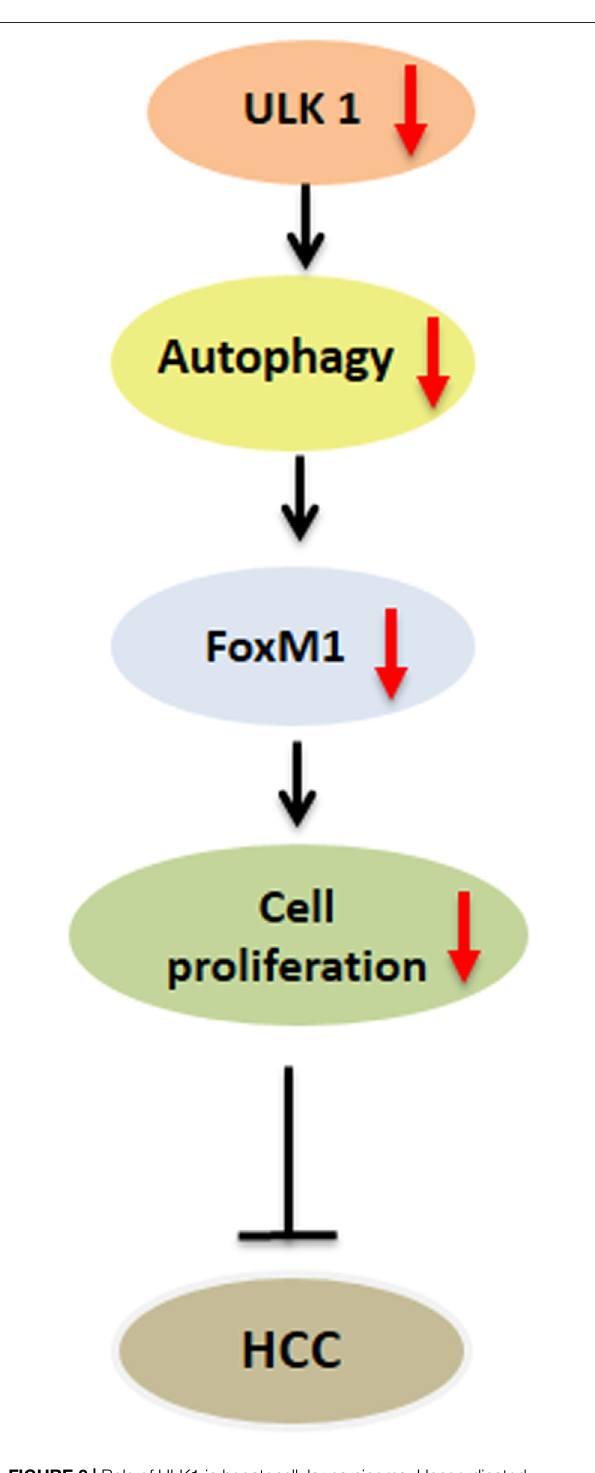
FIGURE 3 | Role of ULK1 in hepatocellular carcinoma. Uncoordinated- 51-like kinases 1 (ULK1)/autophagy inhibition reduces the expression of forkhead box protein M1 (FOXM1) oncogene and its downstream target genesregulatingcellcycleprogressioninhumanhepatomacellsthereby limiting hepatocellular carcinoma (HCC)